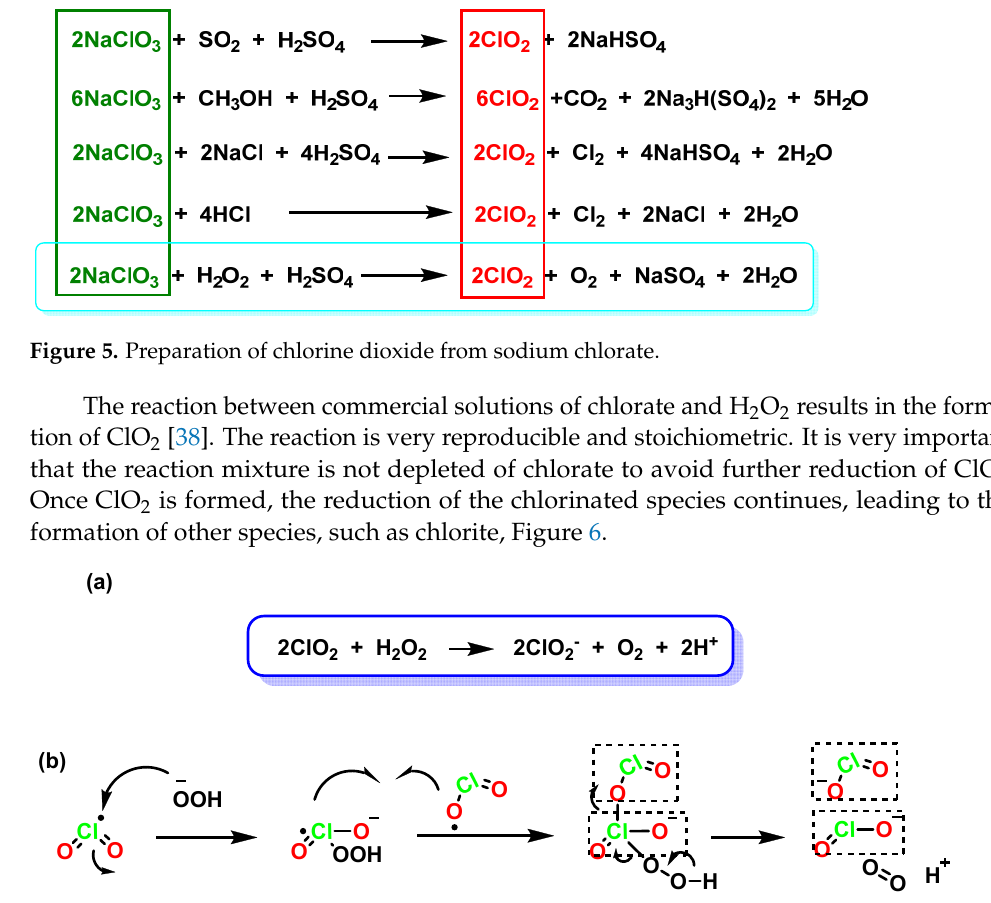
Figure 6. ( a ) Reduction of chlorine dioxide with hydrogen peroxide. ( b ) Reduction mechanism of chlorine dioxide with hydrogen peroxide.